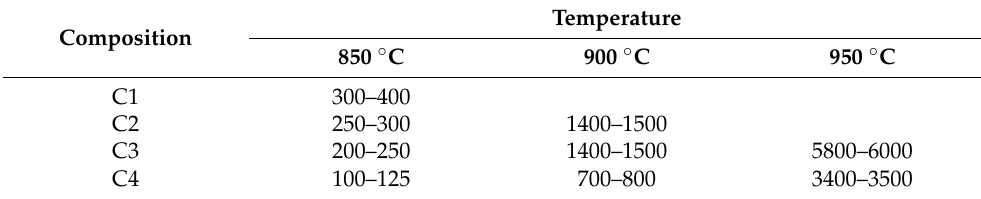
Table 4. Surface crystallization speed in µm/h.